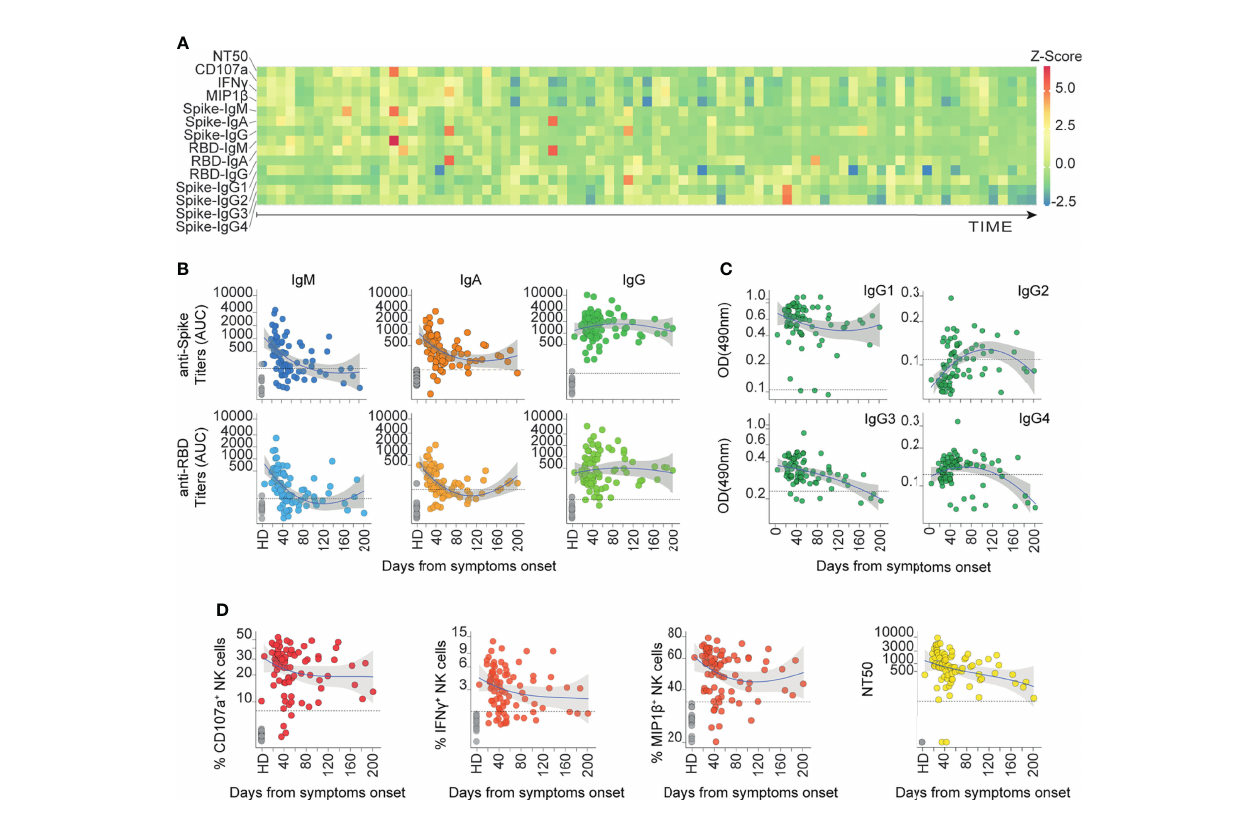
FIGURE 1 | The humoral response mounted against SARS-CoV-2 Spike is heterogeneously represented up to 6 months after the onset of symptoms in COVID-19 outpatients. (A) Heatmap showing the humoral immune response for each patient ordered from the earliest to the latest collected sample (83 COVID-19 samples from 70 donors). The color scale represents the Z-scores calculated independently for each variable. (B) Spike and RBD-speci fi c titers for IgM, IgA, and IgG antibodies measured as AUC (Area Under Curve) are displayed according to their respective sampling day from the onset of symptoms (83 COVID-19 samples from 70 donors and 14 controls). Loess estimation curve for COVID-19 samples is displayed in blue with gray-area indicating standard-error. Dotted line indicates the threshold of mean values from healthy donors plus two standard deviations. (C) Spike-speci fi c IgG1, IgG2, IgG3, and IgG4 sub-class Abs measured as OD490 values are displayed according to their respective sampling day from the onset of symptoms (83 COVID-19 samples from 70 donors and the mean of controls). Loess estimation curve for COVID-19 samples is displayed in blue with gray-area indicating standard-error. Dotted line indicates the threshold of mean values from healthy donors. (D) Spike-speci fi c functions of sera are displayed according to their respective sampling day from the onset of symptoms. Ab-dependent NK degranulation, measured as the frequency of CD107a + NK cells; Ab-dependent NK activation, measured as the frequency of IFN g + and MIP1 b + NK cells; plus their neutralizing ability, measured as NT50 values (83 COVID-19 samples from 70 donors and 14 controls). Loess estimation curve for COVID-19 samples is displayed in blue with gray-area indicating standard-error. Dotted line indicates the threshold of mean values from healthy donors plus two standard deviations. Dotted line in NT50 indicates the reciprocal of the initial sera dilution used in the